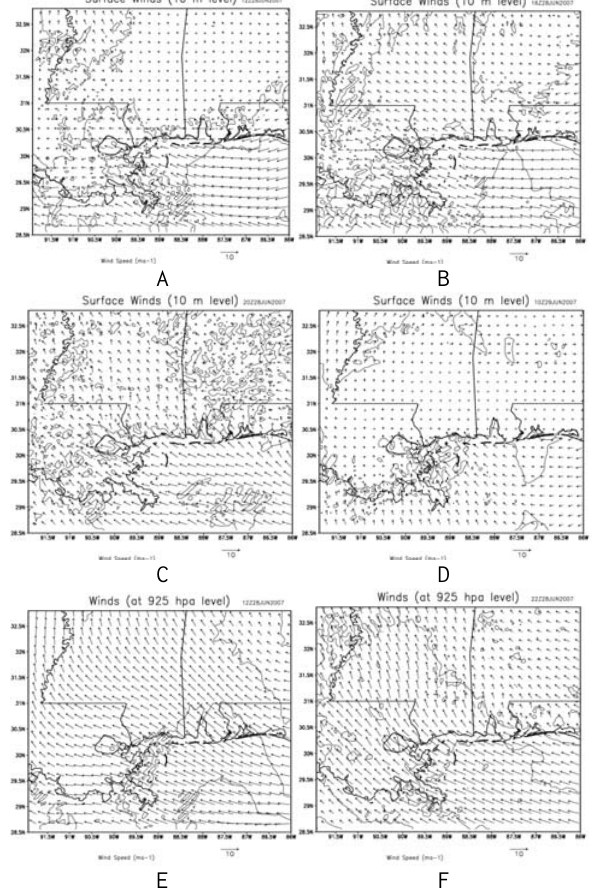
Figure 9 : Simulated wind pattern in the MS Gulf coast region for28-29 June, 2007. Panels a,b,c,d-for the surface wind and panels e,f-for winds at 925 hPa (~1km) level.